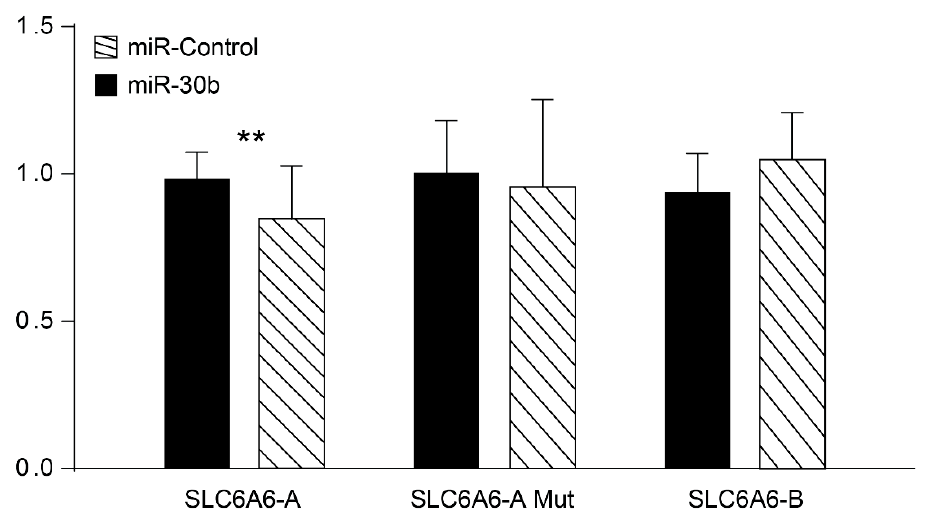
Figure 4. miR-30b target SLC6A6 expression. Luciferase reporter assays of HEK-293 cells transduced with pre-miR-30b or a control miR, and transfected with the 3 ′ -UTR of SLC6A6-A wild-type, SLC6A6-A mutated in the target sequence, or SLC6A6-B lacking the predicted miR-30b binding site. Luciferase activity was normalized to that of control-transfected cells. Data shown as mean ± SEM of triplicates per experiment ( n = 3). ** p < 0.005.